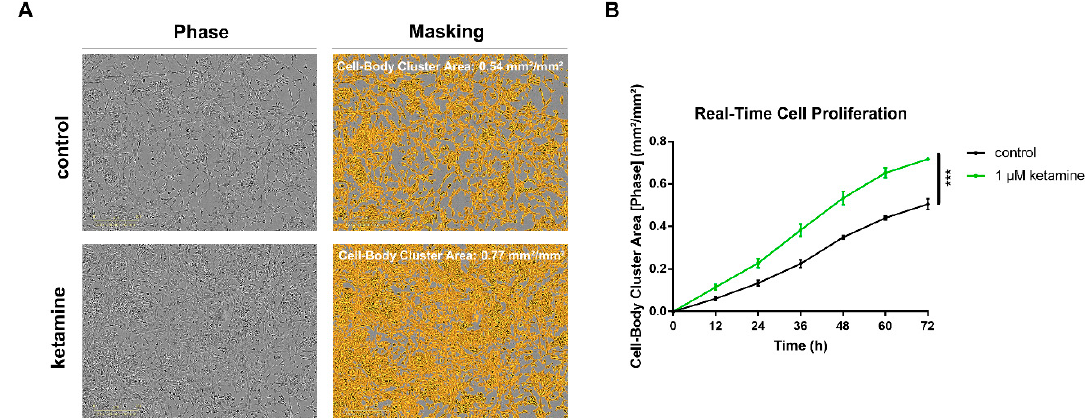
Figure 2. Ketamine increased cell proliferation of human iPSC-derived IMR90 NPCs. ( A ) Automated phase-contrast image segmentation using the IncuCyte ® NeuroTrack Software after 72 h treatment, scale = 300 µm. Confluency of cells was determined with IncuCyte ® NeuroTrack Software indicated as Cell-Body Cluster Area. ( B ) Phase-contrast imaging was performed using the IncuCyte ® Zoom time-lapse microscopy system at 37 °C for a period of 72 h. NPCs were treated with either 1 µM ketamine or 0.01% dimethyl sulfoxide (DMSO) control. The data represent means of three independent experiments, and the error bars were calculated using ± SEM.